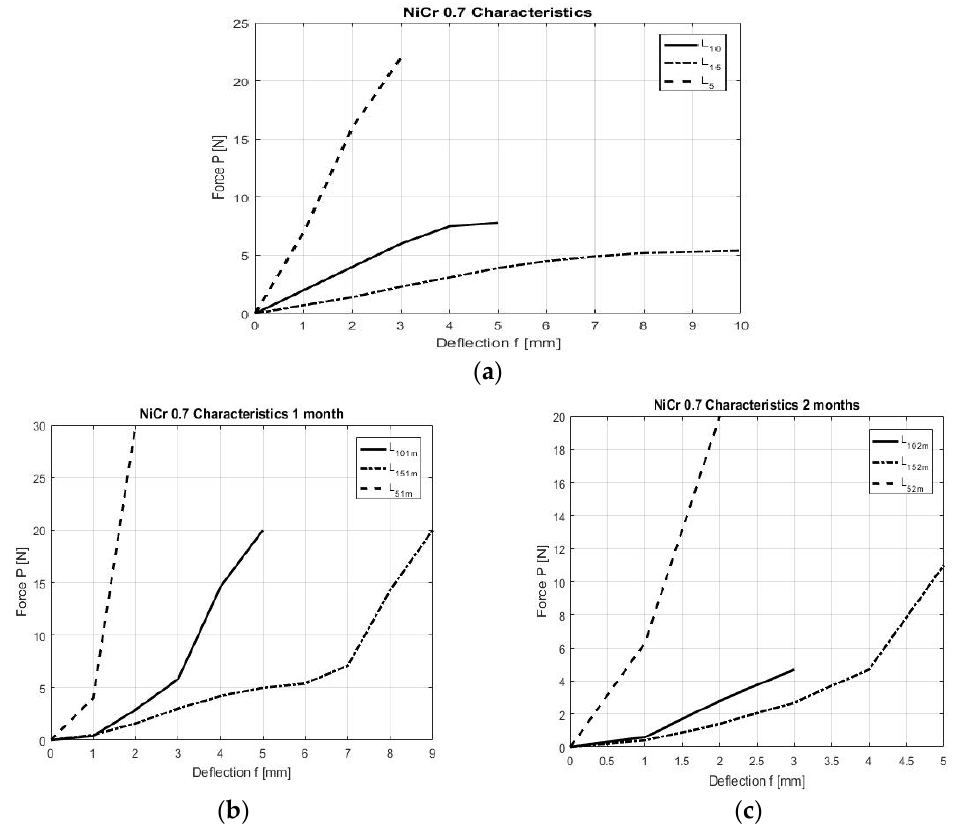
Figure 7. ( a ) Ni-Cr bending with a diameter of 0.7 mm without attack. A linear behavior is observed for each length of the arc. ( b ) NiCr bending with saliva attack, 1 month; ( c ) NiCr bending with saliva attack, 2 months. Table 2. Results for Co-Cr 0.7 mm